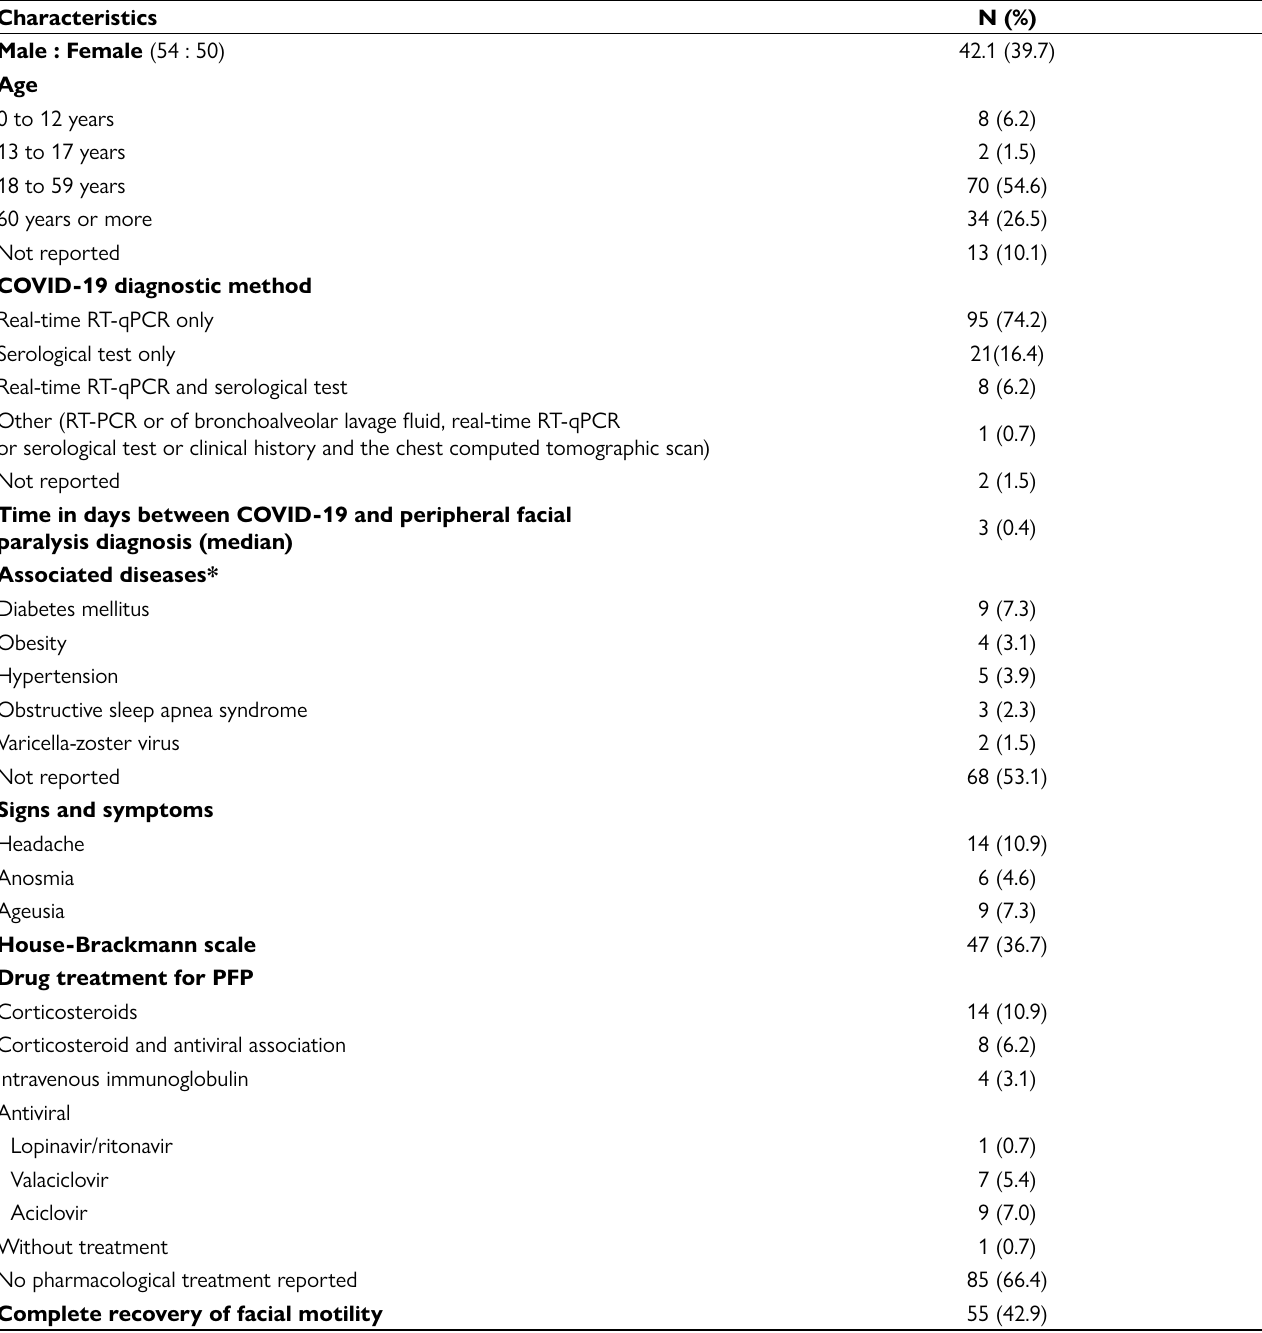
Table 2. Clinical features of patients with peripheral facial paralysis after COVID-19 (n = 127)